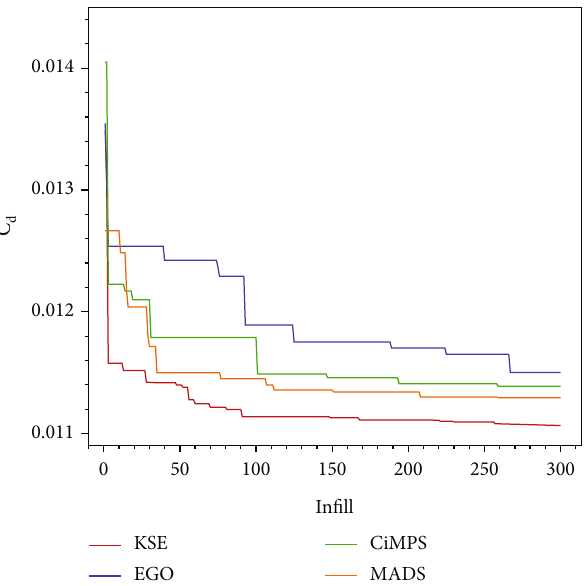
Figure 16: Mean convergence of best objective function values in 10